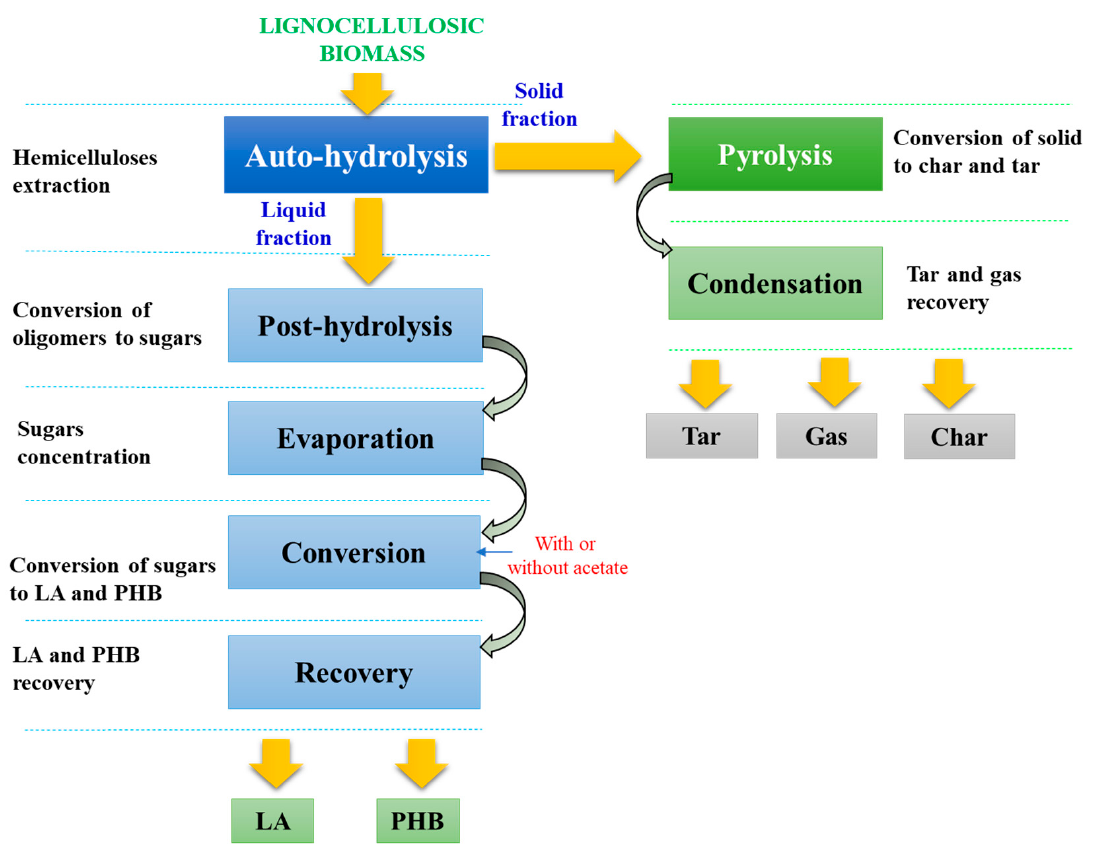
Figure 1. Processing scheme for hemicellulose valorization from the autohydrolysis liquid fraction.